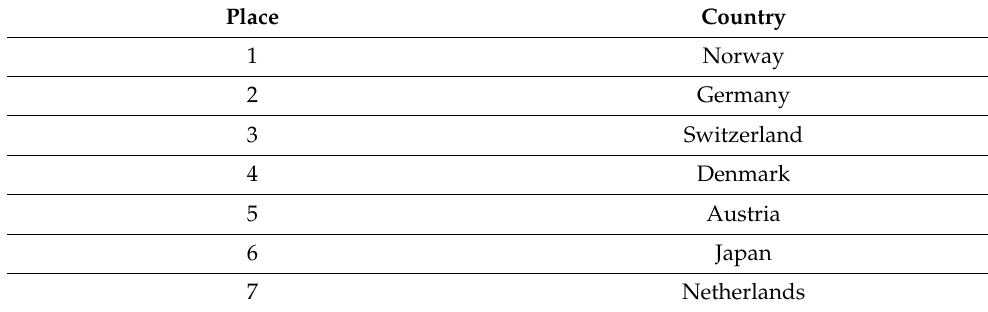
Table 6. Ranking of health care systems in selected OECD